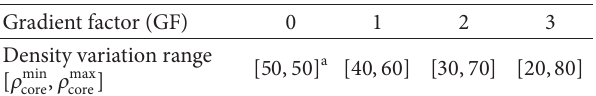
Table 2: Gradient factor.